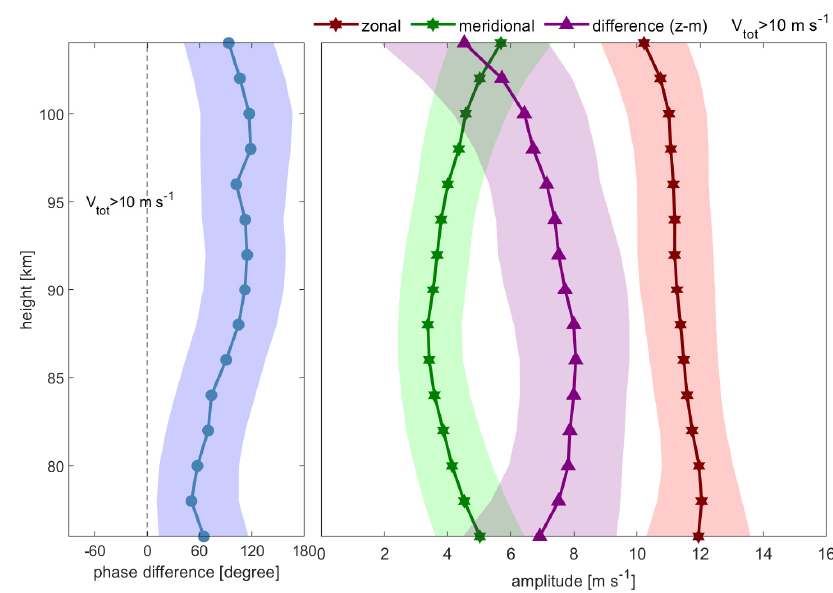
Figure 8. Left panel : the mean of the phase difference (blue dots and line) between the zonal and meridional components during 2014–2022. The blue shadings indicate their standard deviations. Right panel : the 2014–2022 mean zonal (red stars and line) and meridional (green stars and line) amplitudes as well as their standard deviations (red and green shading). Amplitude differences with standard deviation are shown in purple triangles, lines, and